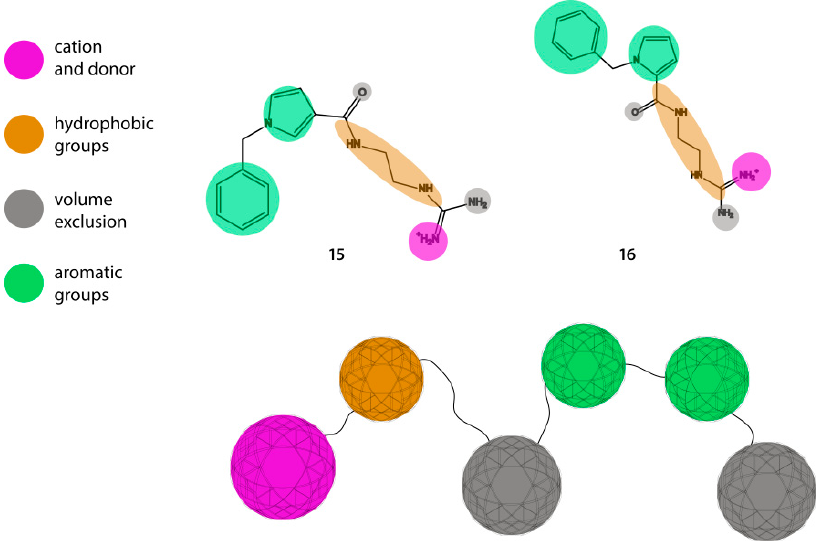
Figure 12. Structure-based pharmacophore derived from ZINC database data.